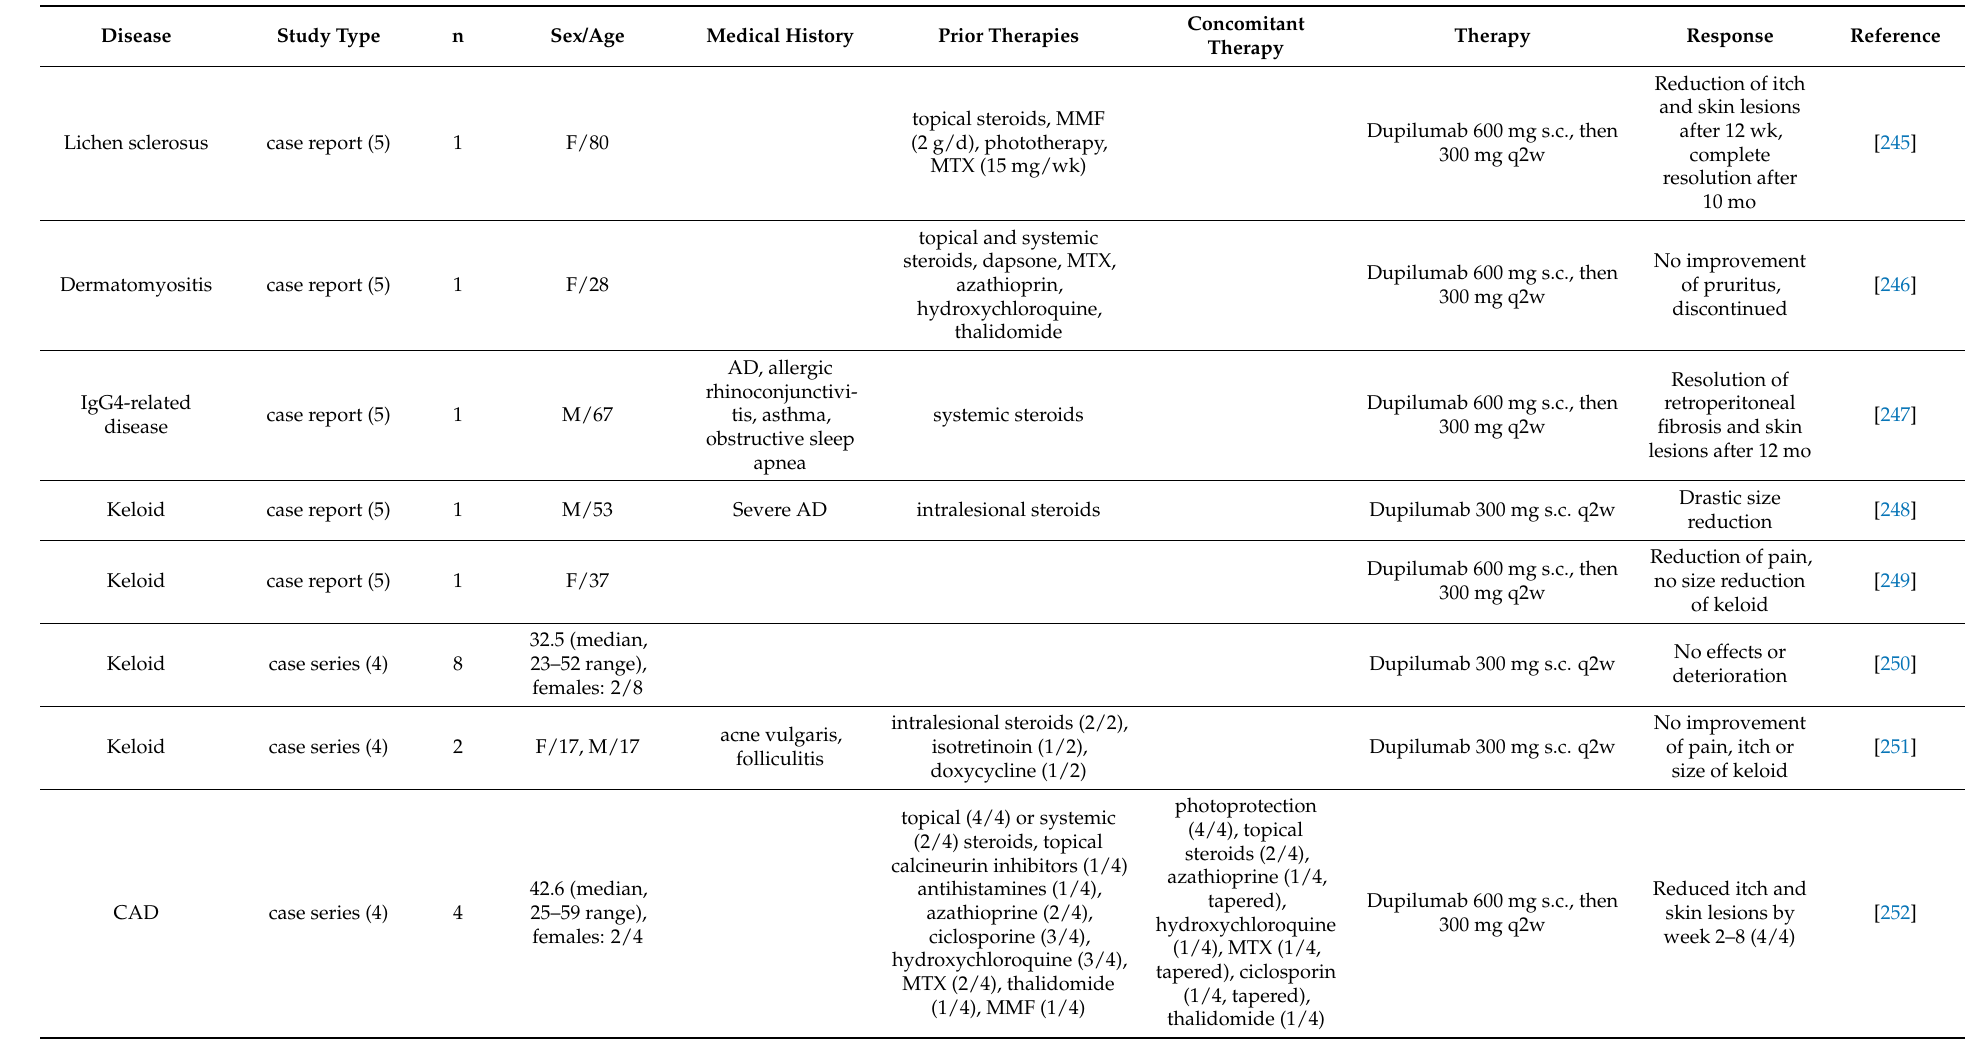
Table 8. Connective tissue disorders and other inflammatory skin